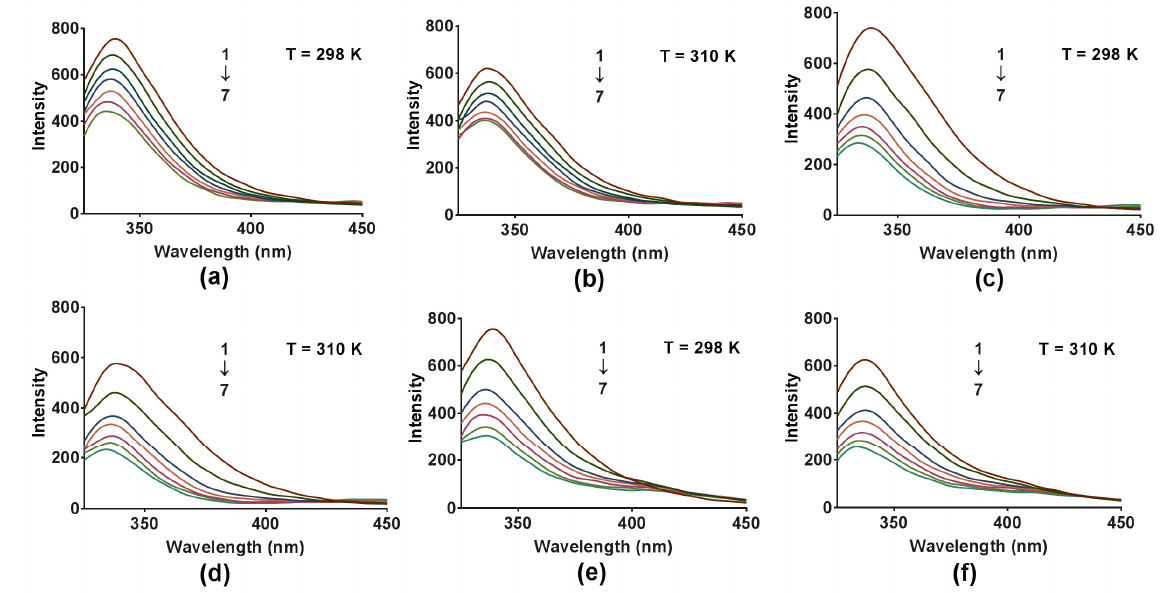
Figure 4. Spectra of COX2 (6.0 × 10 − 8 mol · L − 1 ) fluorescence quenching upon binding to compounds DB2 ( a , b ), SC2 ( c , d ) or YB2 ( e , f ) (1 → 7: 0, 0.75, 1.50, 2.25, 3.00, 3.75, 4.50 × 10 − 5 mol ∙ L − 1 ) at 298 K and 310 K.